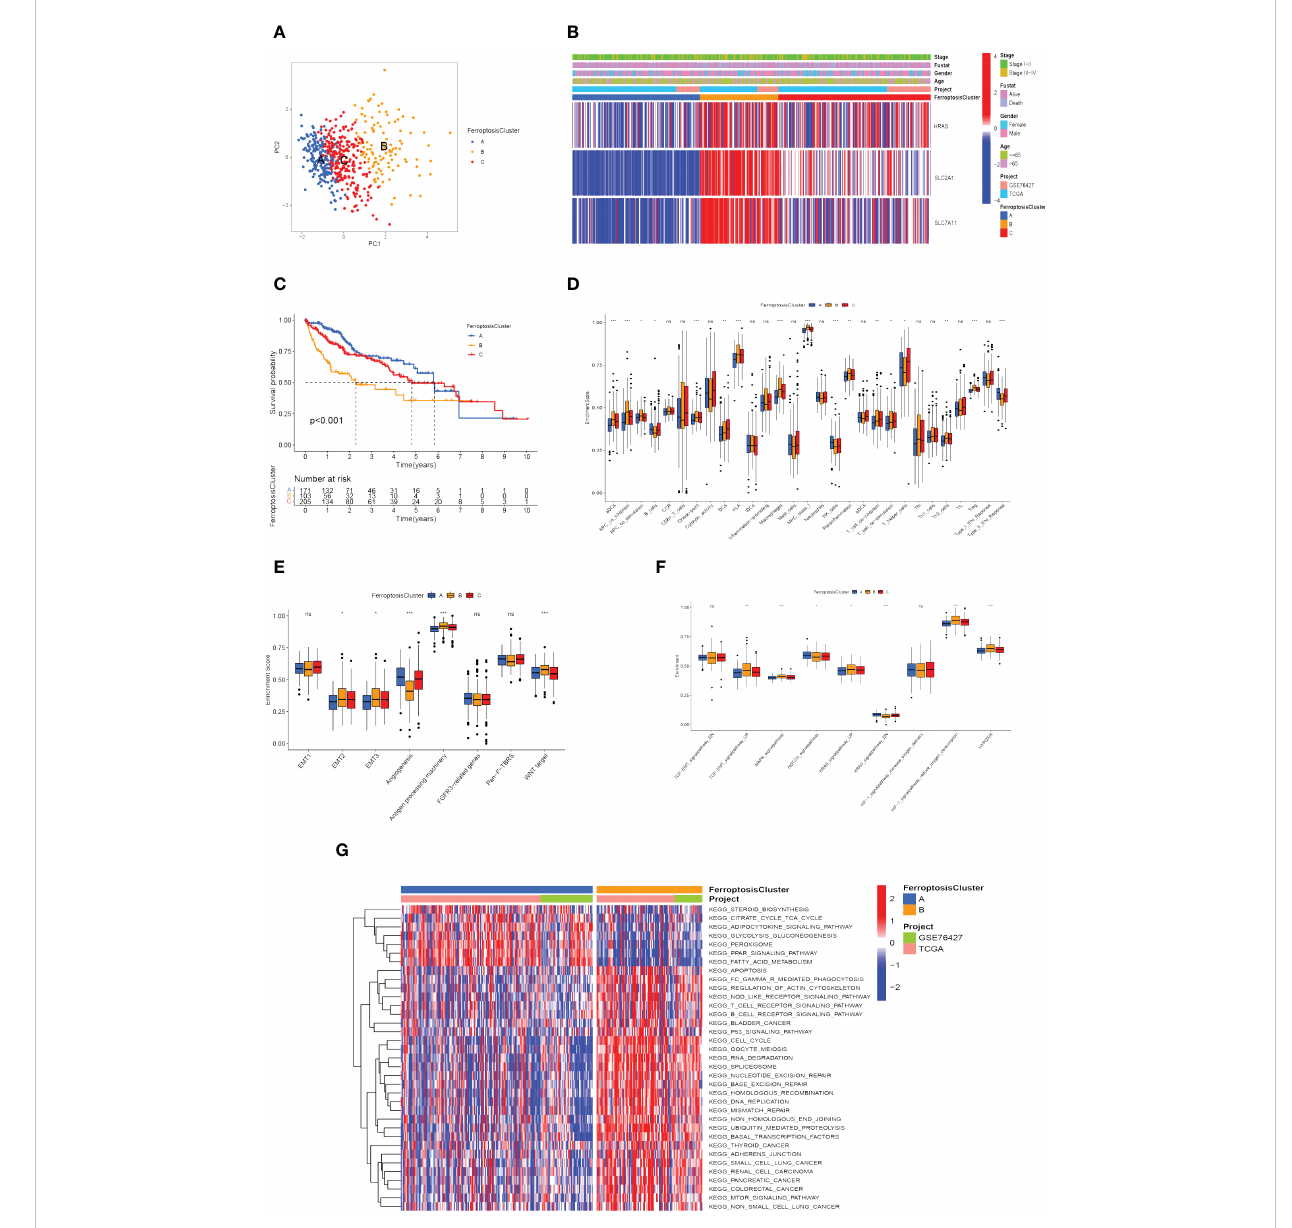
FIGURE 4 Recognition offerroptosis molecular patterns with speci fi c TME features and functional enrichment analysis. (A) Principal component analysis of hub gene expression pro fi les distinguished three ferroptosis clusters, A (blue), B (yellow), and C (red). (B) Heat map displaying the correlation between the hub genes expression and ferroptosis clusters. (C) Kaplan-Meier curves for the three molecular patterns of HCC patients. (D) Box plots displayed the levels of immune in fi ltration in the three patterns. ns, not signi fi cant; * p <0.05; ** p <0.01; *** p <0.001. (E, F) Differences in stromal activation pathway (E) and carcinogenesis-related pathways (F) in the three ferroptosis clusters. ns, not signi fi cant; * p <0.05; ** p <0.01; *** p <0.001. (G) GSVA analysis revealed distinct activations of biological pathways in ferroptosis clusters. Blue represented the inhibition pathway and red represented the activation